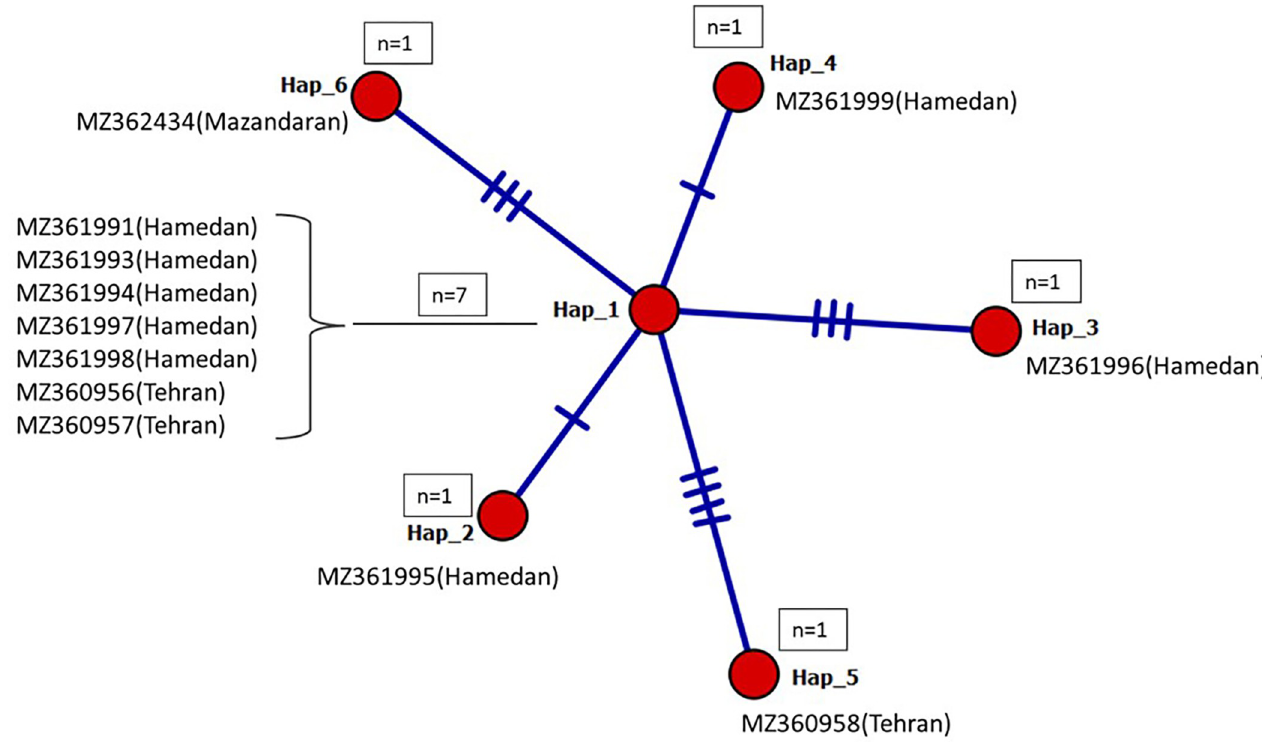
Fig 3. Median-Joining haplotype networks analysis of cox 1 gene (378 bp) based on 12 isolates of E . vermicularis constructed using PopArt 1.7. Six haplotypes were identified within the isolates in the current study. The details of the sequence(s) belonging to each haplotype are noted. Each circle represents a unique haplotype, n represents the number of sequences in each haplotype, and the hatch marks along the network branches indicate the number of mutations.